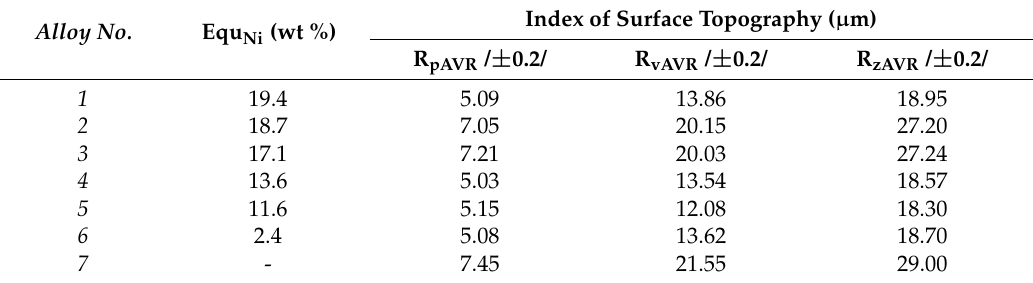
Table 3. Indices determining surface topography after abrasive-wear tests. Alloy No.